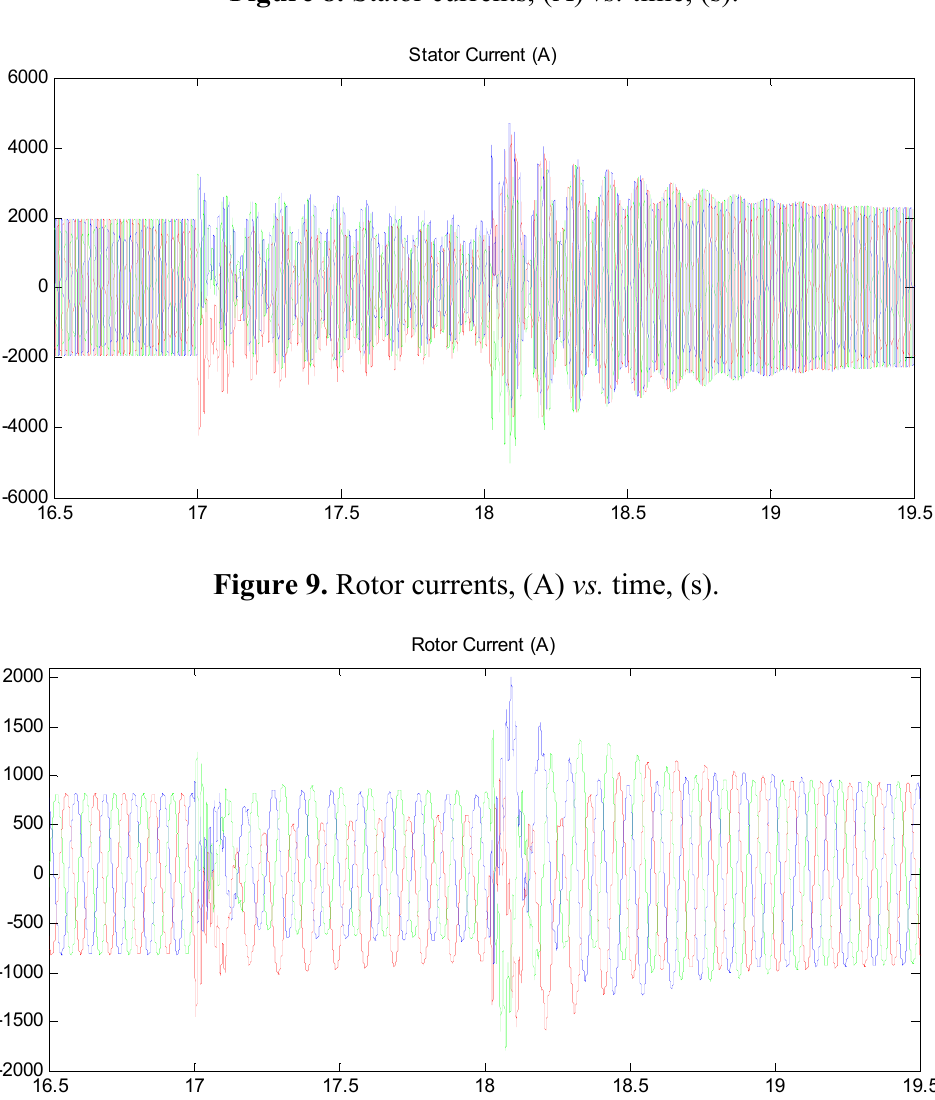
Figure 8. Stator currents, (A) vs. time, (s).